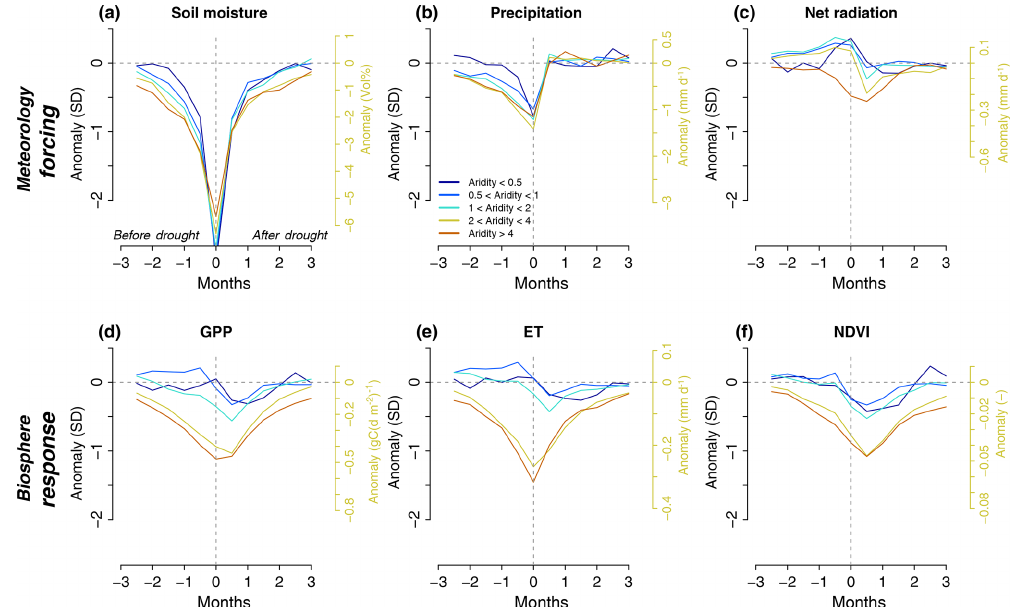
Figure 2. Aridity-specific time evolution of meteorological forcing (a–c) and biospheric response (d–e) during drought. Evolution for each variable computed as a composite across all grid cells of the respective aridity regions. To ensure comparability of anomalies across vari- ables, values are normalized by and expressed as the inter-annual standard deviation of each variable ( z scores, left axes). Normalization is performed by dividing the actual anomalies (right axes, example for aridity values between 2 and 4) through the typical aridity-specific variability as expressed by the inter-annual standard deviation across all absolute, half-monthly growing season anomalies averaged across all grid cells of each aridity region.